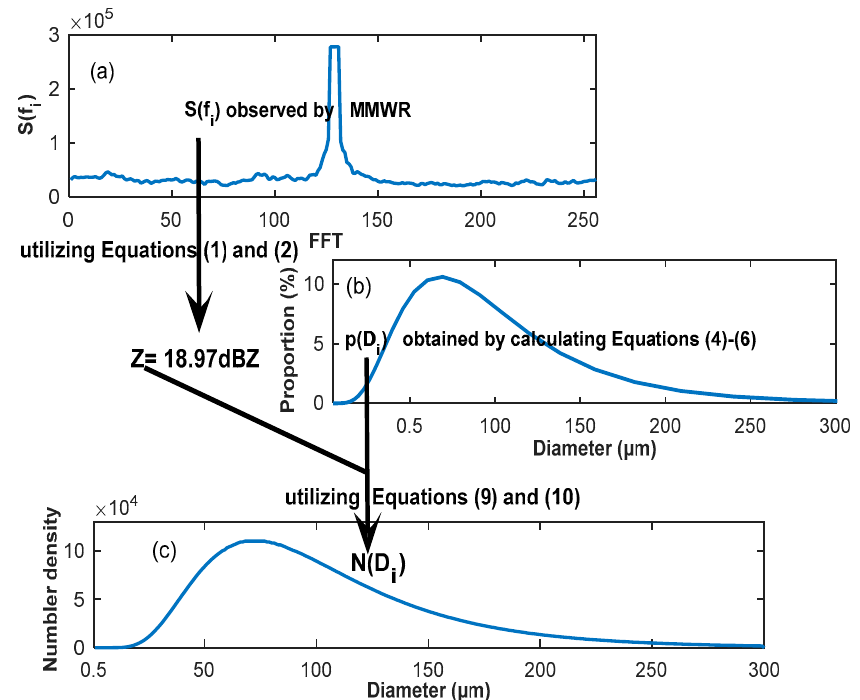
Figure 2. The retrieval process of th e dust spectrum distribution. ( a )The power spectrum S(f (cid:2919) ) . ( b )The particle probability distribution p(D (cid:2919) ) . ( c )The dust spectrum distribution N(D (cid:2919)